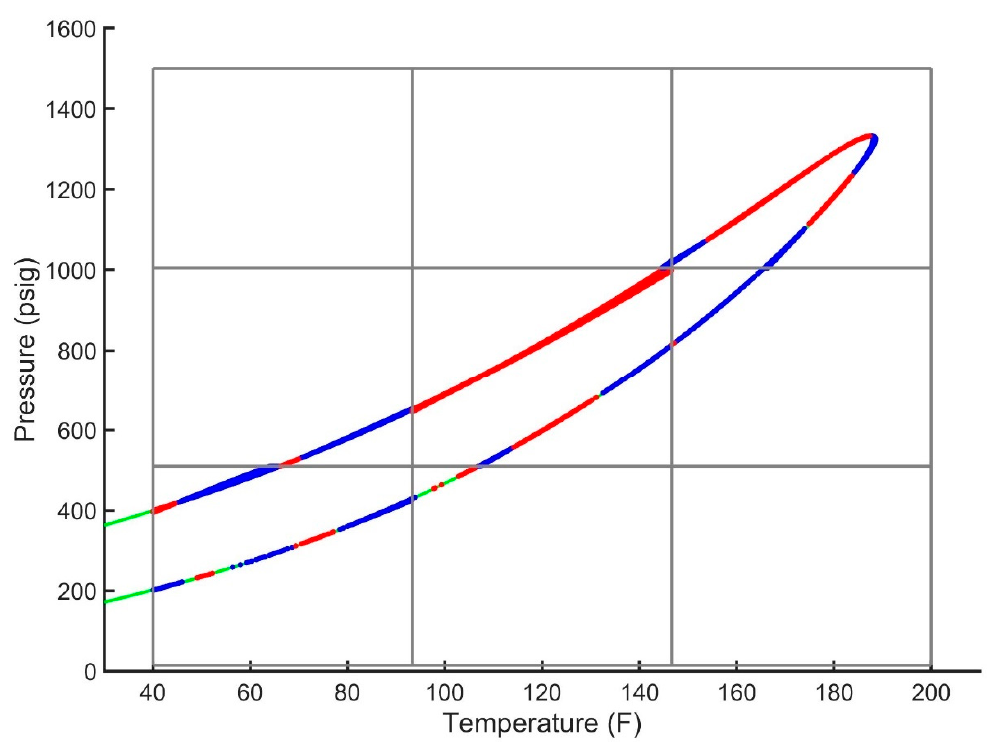
Figure 10. Visualization of the 3 × 3 split neural network model results on testing datapoints (86% H 2 S). Table 5. Number of hidden neurons in each submodel.